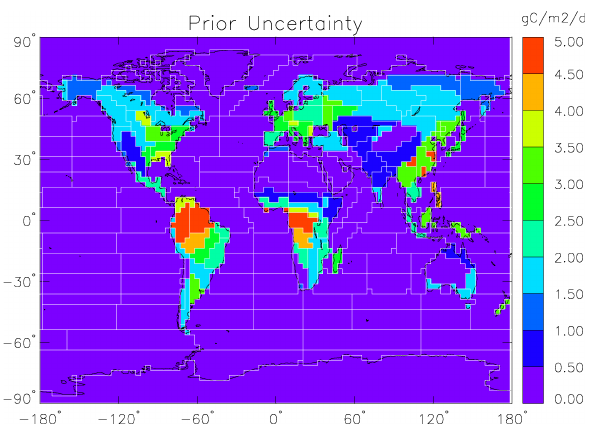
Fig. 1. Prior uncertainty of weekly fluxes in gCm − 2 d − 1 . The white lines show the borders of the 200 regions for which the surface fluxes are retrieved.